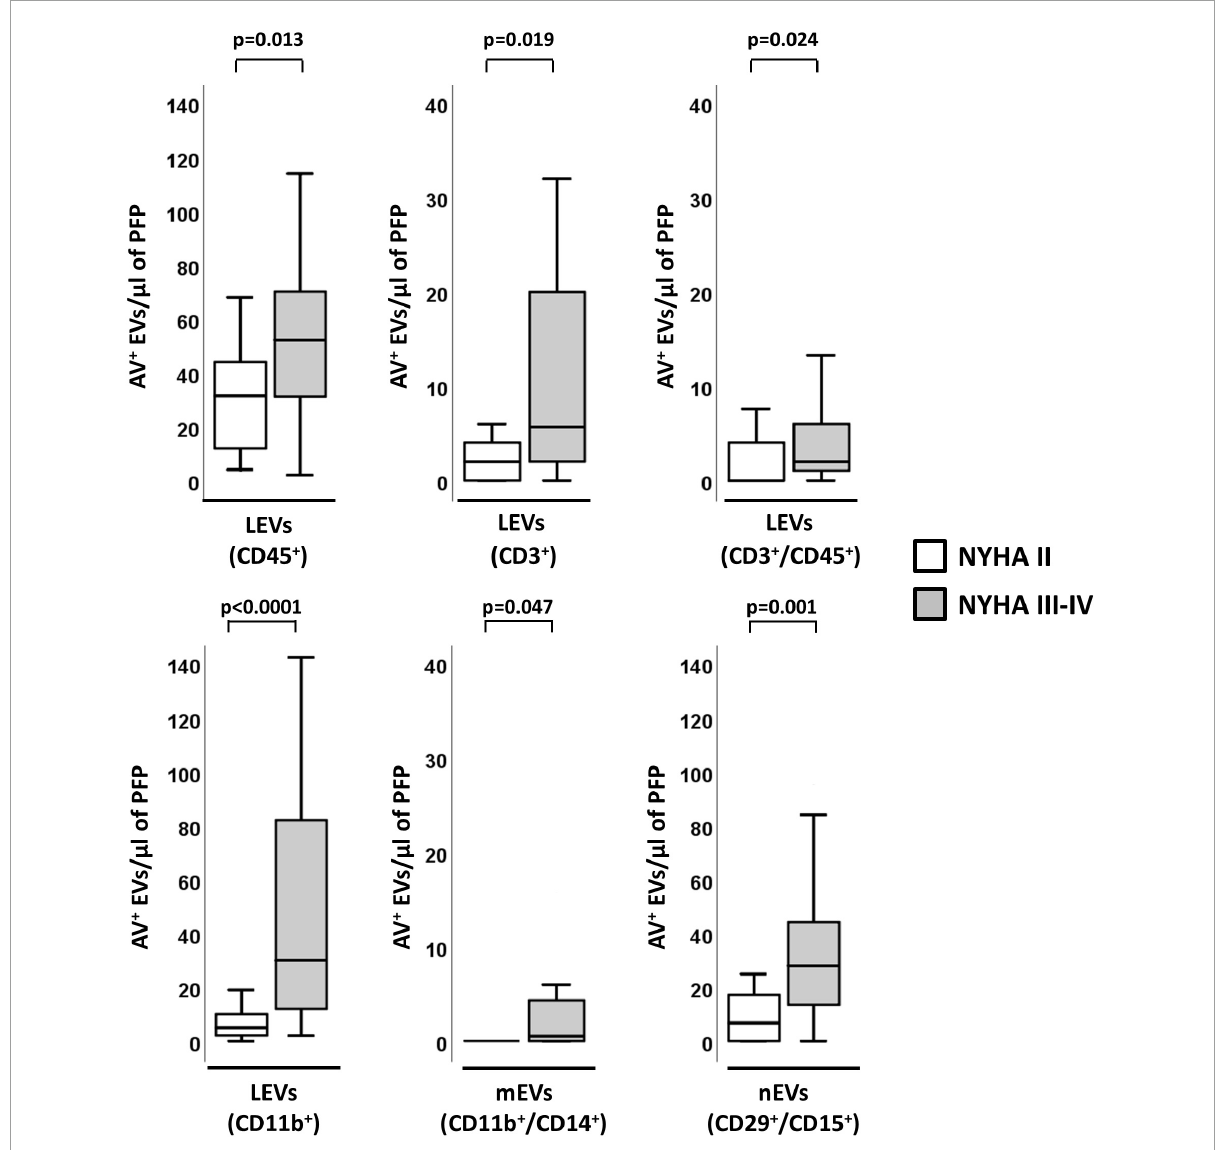
FIGURE4 Distribution of AV + -EVs of immune-cell origin considering disease severity in ischemic patients. Distribution of EVs of total leukocytes (CD45 + ), T-lymphocytes (CD3 + and CD3 + /CD45 + ), activated leukocytes (CD11b + ) and from activated monocytes (CD11b + /CD14 + ) and activated neutrophils (CD29 + /CD15 + ). A p < 0.05 was considered significant (U Mann–Whitney test). AV + , annexin V + ; EVs, extracellular microvesicles; LEVs, leukocyte-derived EVs; lEVs, lymphocyte-derived EVs; mEVs, monocyte-derived EVs; nEVs, neutrophil-derived EVs; NYHA, New York Heart Association; PFP, platelet-free